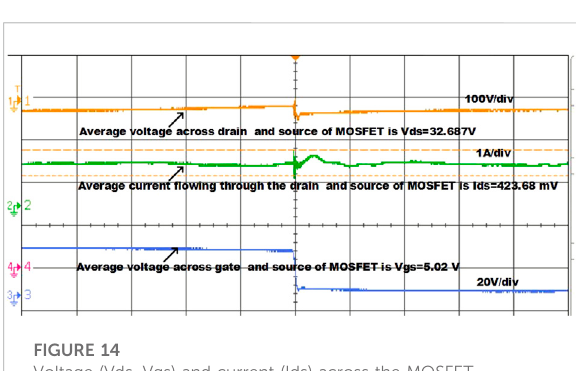
FIGURE 12 Proposed converter ’ s superior qualities compared to certain current converters are depicted in a radial chart.